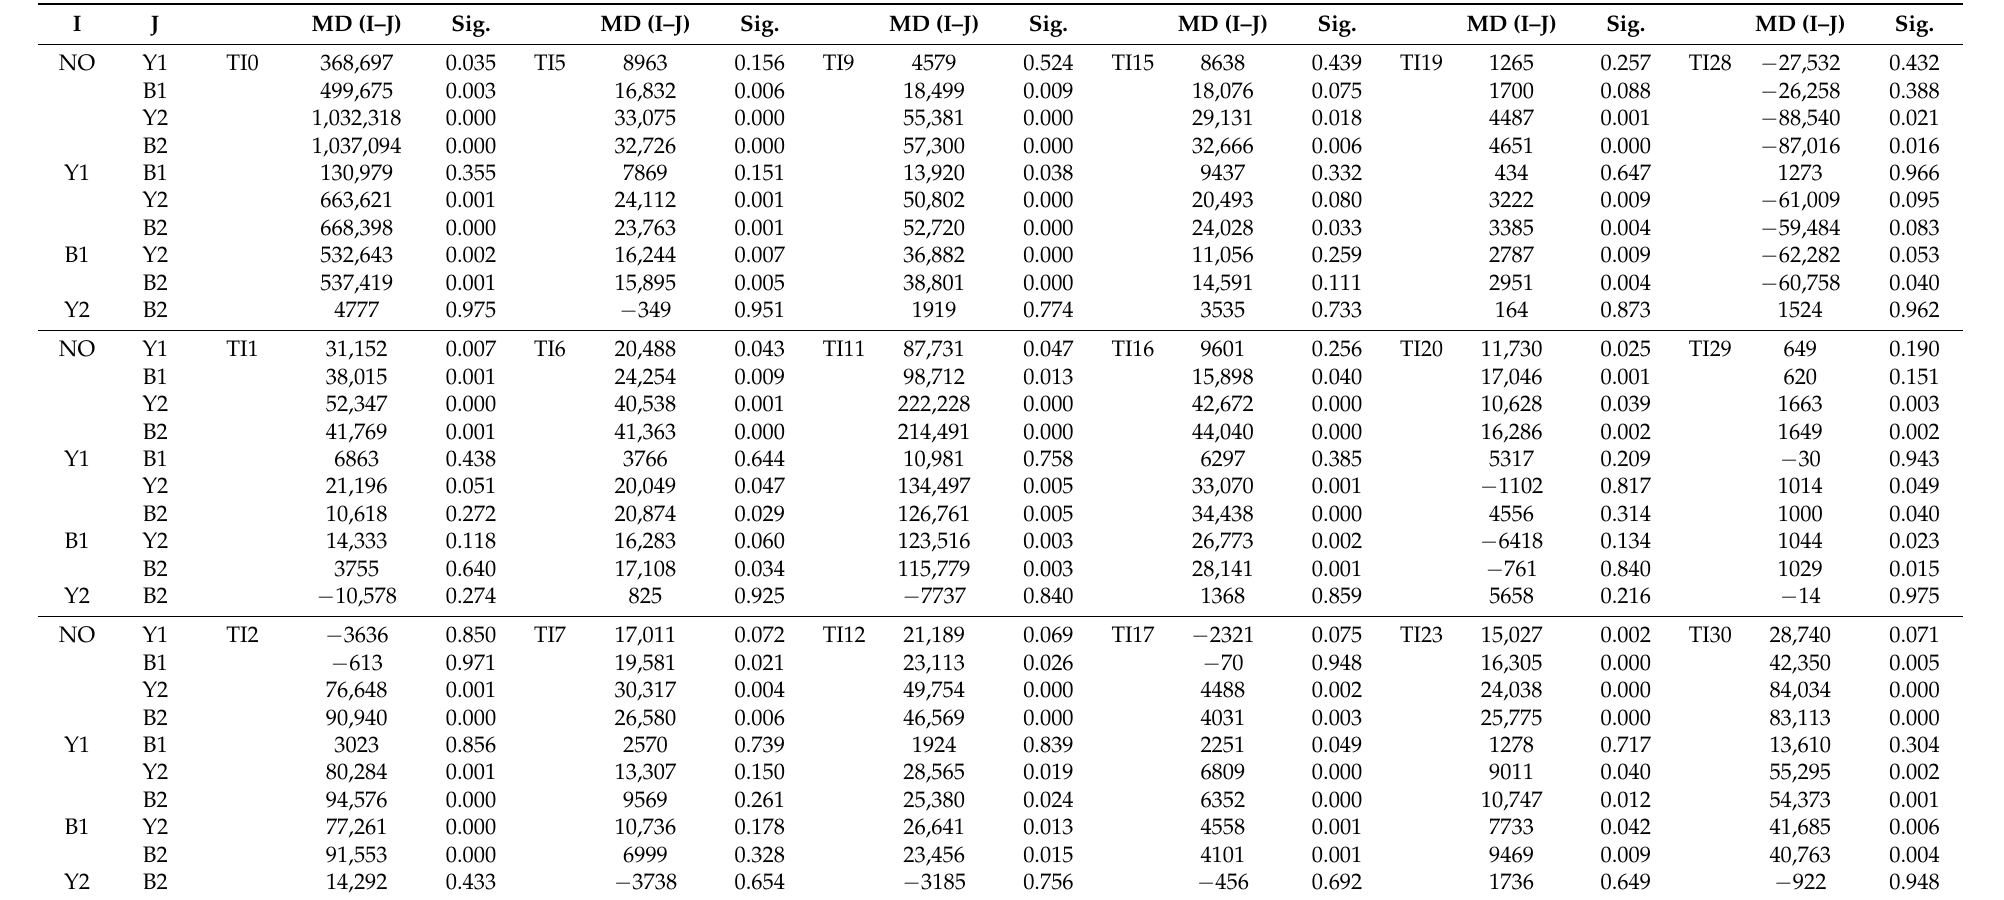
Table A1. Total income—post hoc tests—multiple comparisons using